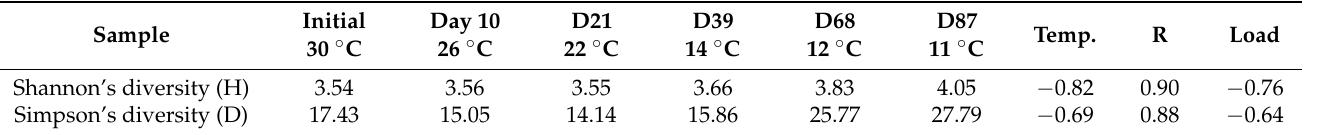
Table 2. Shifts in Shannon’s and Simpson’s diversity index values during experiment with correlations to modifications of temperature, NH 4 -N load and R